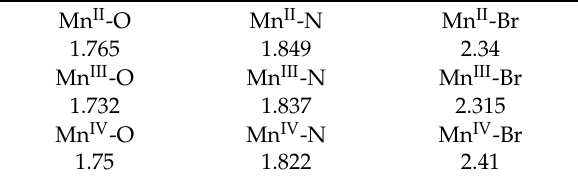
Table 4. r 0 ’s value for Mn with di ff erent charges bonds to O, N, and Br